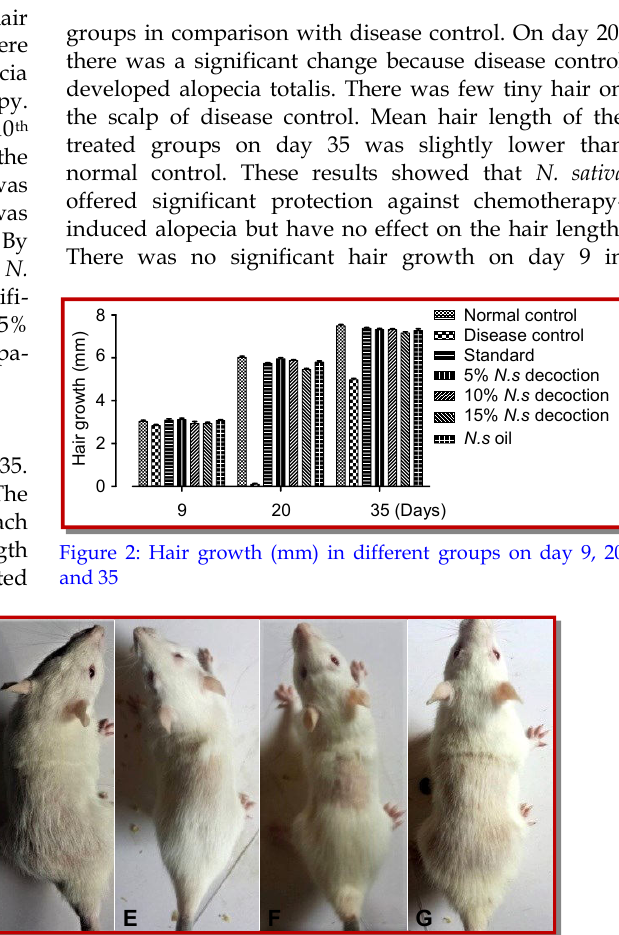
Figure 1: Macroscopic changes in different groups on 10 th day on chemotherapy; A: normal control, B: disease control, C: stand- ard, D: 5% N. sativa decoction, E: 10% N. sativa decoction, F: 15% N. sativa decoction, G: N. sativa oil